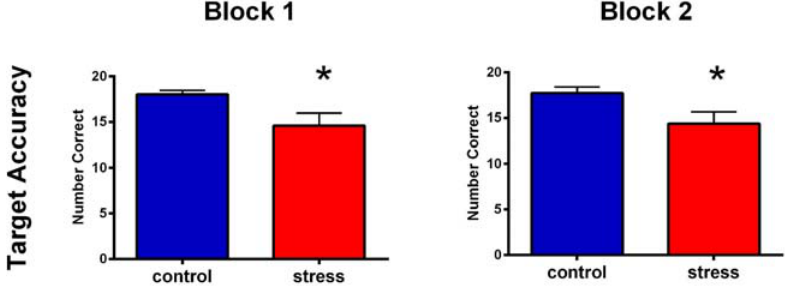
Figure 4. SART performance. There was impaired target accuracy and delayed reaction time on the SART at 15 min and 30 min following stress (black bars represent 1 standard error). Asterisks indicate a statistical difference between stress and control condition at p <